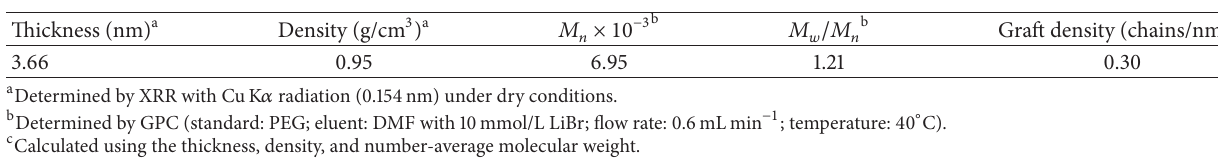
Table 1: Characterization of the grafted